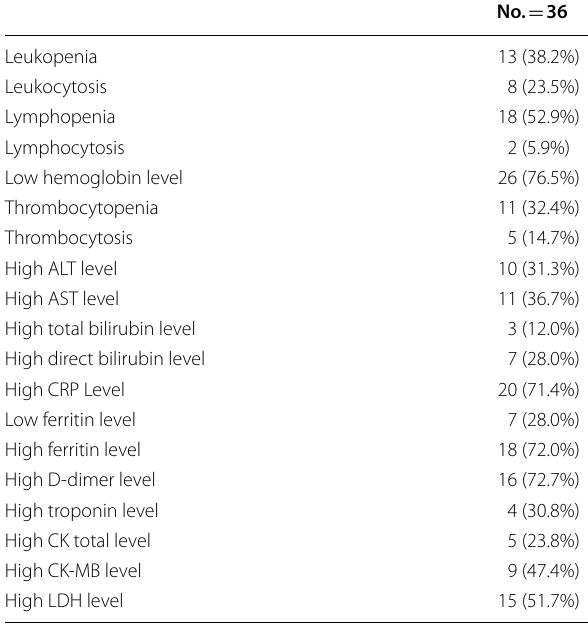
Table 2 Presenting important lab results done to the